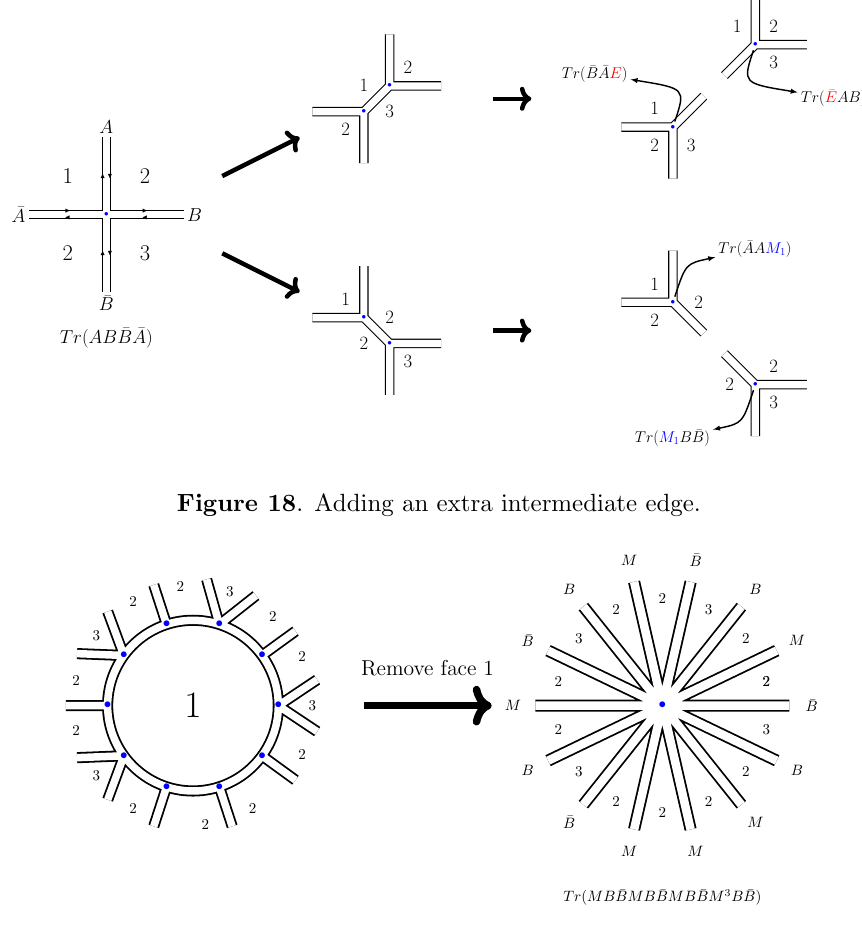
Figure 19 . Vertices organize around a reference